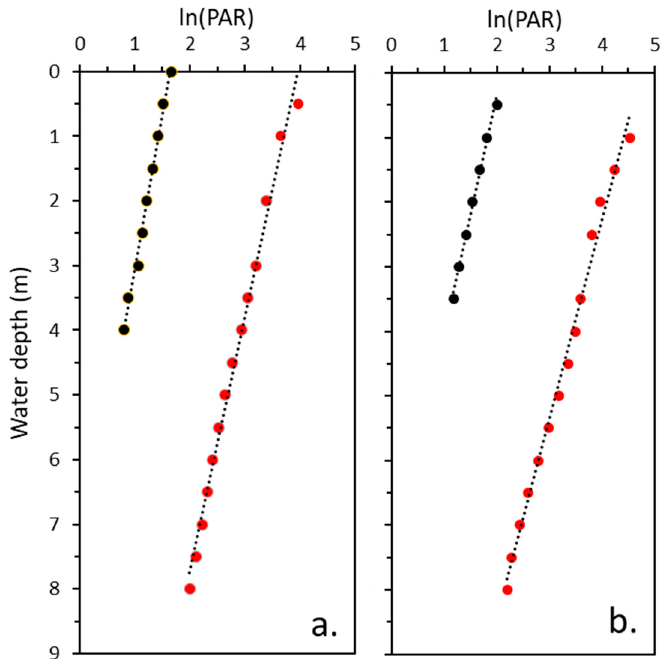
Figure 4. The ln(PAR) for downwelling ( • ) and upwelling ( • ) PAR versus depth below the sea ice with ( a ) and without ( b ) a snow cover. Table 1. Diffuse attenuation coefficients for downwelling PAR—K d (PAR) and upwelling PAR K u (PAR), under-ice downwelling PAR (I 0d ), and under-ice upwelling PAR (I 0u ), irradiance reflectances with (+Snow) and without snow ( − Snow). Average downwelling surface PAR during sampling period was 546.4 µmol photons m − 2 s − 1 .